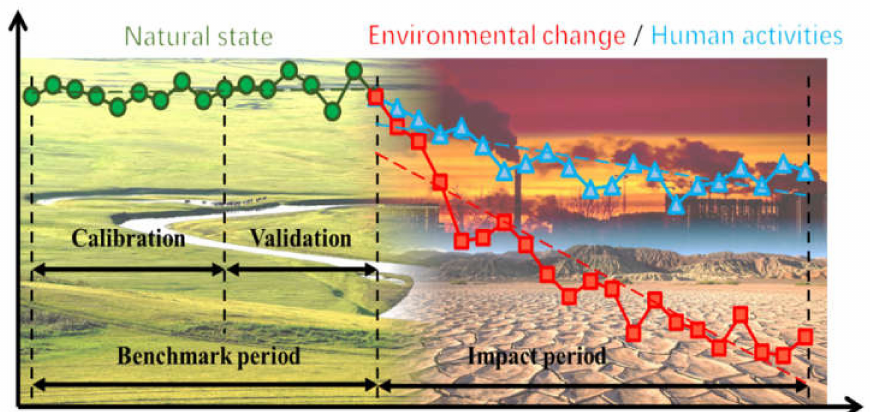
Figure 2. Framework for evaluation of impacts of climate change and human activities on runoff for the decreasing